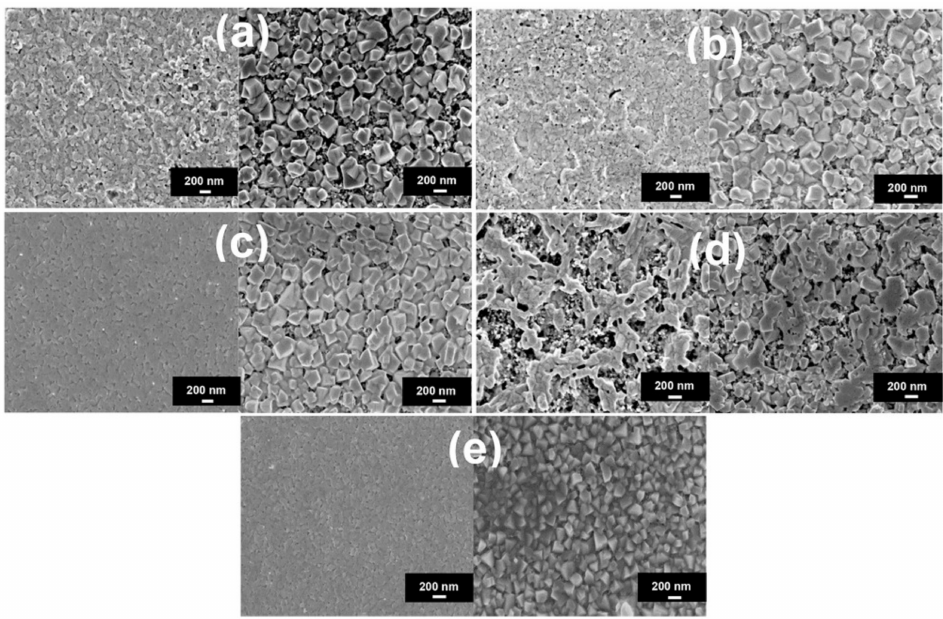
Figure 1. SEM images of monovalent cation doped PbI 2 (left) and MAPbI 3 (right) for every panel. The dopants used are: ( a ) no doping; ( b ) CuBr; ( c ) CuI; ( d ) NaI; ( e ) AgI. Reproduced with permission from Adv. Energy Mater. 2016 , 6 , 1502472, Reference